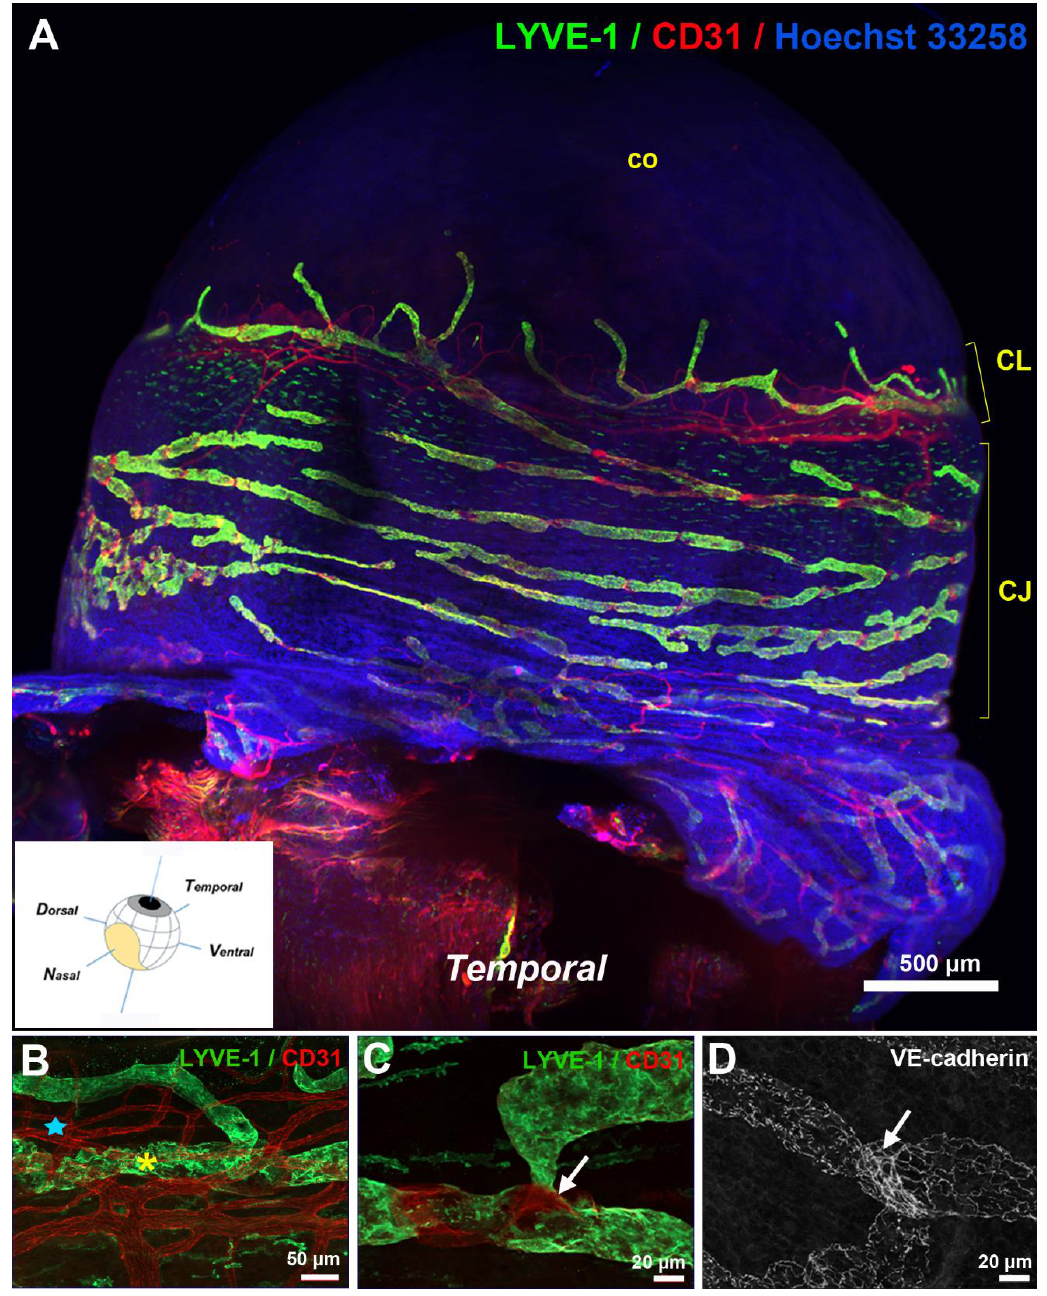
Figure 2. Visualization of the ocular surface lymphatics after whole-mount immunostainings. ( A ) Light sheet fluorescence imaging view of the temporal side of a left mouse eye with LYVE-1 (green) and CD31 (red) antibodies. Nuclei counterstaining was performed with Hoechst 33258 (blue). CJ, conjunctiva; CL, corneolimbus; co, cornea. The inset image, modified from [27], shows a schematic view of the cardinal axes of the left eye and the position of the nictitating membrane (drawn in yellow). ( B – D ) Imaging at high magnification of the corneolimbal ( B ) and the conjunctival ( C , D ) blood and lymphatic vasculature after whole-mount fluorescence immunostaining and flat mounting of the dissected eye anterior segment. LYVE-1-positive staining marks lymphatic vessels (yellow asterisk) whereas blood vessels (blue star) of the corneolimbus are revealed by the sole CD31-positive staining. The gap in the LYVE-1 staining, as illustrated in ( C ), corresponds to the presence of a valve as revealed by the VE-cadherin staining in another similar field in ( D ). On both images, the valve location is pointed by a white arrow. Note the presence of a more or less punctuated VE-cadherin staining depending on the pre- or the post-valve location, that is typical of lymphatic button- or intermediate button/zipper-type of endothelial cell